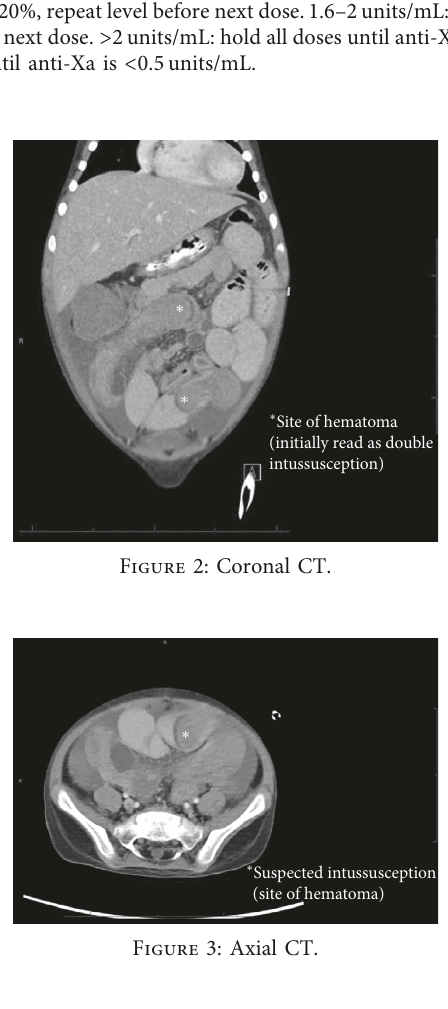
0.35units/mL: increased dose by 25%, <